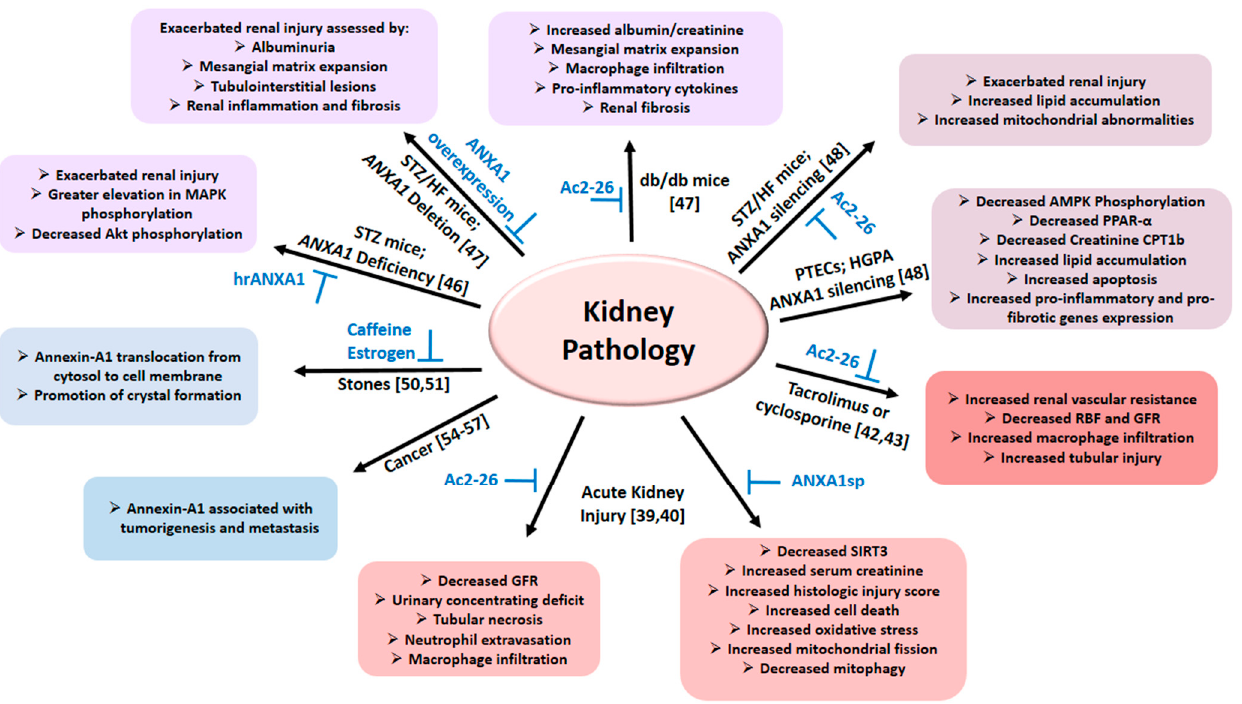
Figure 2. The diagram summarizes the role of Annexin A1 in various pathologies of the kidney as detailed in the text; relevant citations are provided in brackets. Abbreviations: AMPK: Adenosine 5 (cid:48) -monophosphate-activated protein kinase; ANXA1: Annexin A1; Ac2-26: Annexin A1 peptide mimetic; ANXA1sp: Annexin A1 tripeptide mimetic; CTP1b: Carnitine palmitoyltransferase 1b; GFR: Glomerular filtration rate; HFD: High fat diet; HGPA: High glucose palmitic acid; PPAR- α : Proliferator-activated receptor- α ; PTECs: Proximal tubule epithelial cells; RBF: Renal blood flow; Sirtuin-3 (SIRT3); STZ: